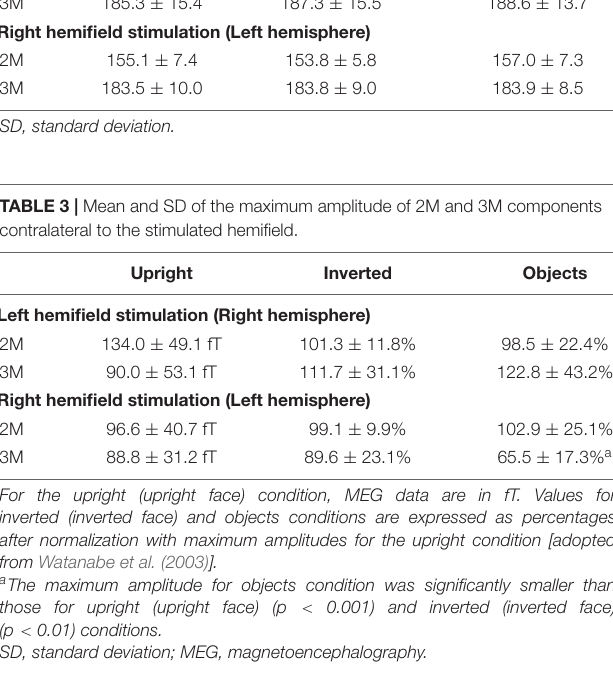
( Figure 6 ): (1) upright contours and upright features (U&U): contours (hair and chin) and features (eyes, nose, and mouth) TABLE 2 | Mean and SD of peak latency (msec) of 2M and 3M components upright, (2) upright contours and inverted features (U&I): contralateral to the stimulated hemifield for upright (upright face), inverted (inverted contours remained upright, but the features were mirrored and face), and objects conditions [adopted from Watanabe et al. (2003)]. inverted relative to the U&U condition, although the spatial relationship among the features was not changed, and (3) Upright Inverted Objects inverted contours and inverted features (I&I): A mirrored and inverted form of the image used in the U&U condition.